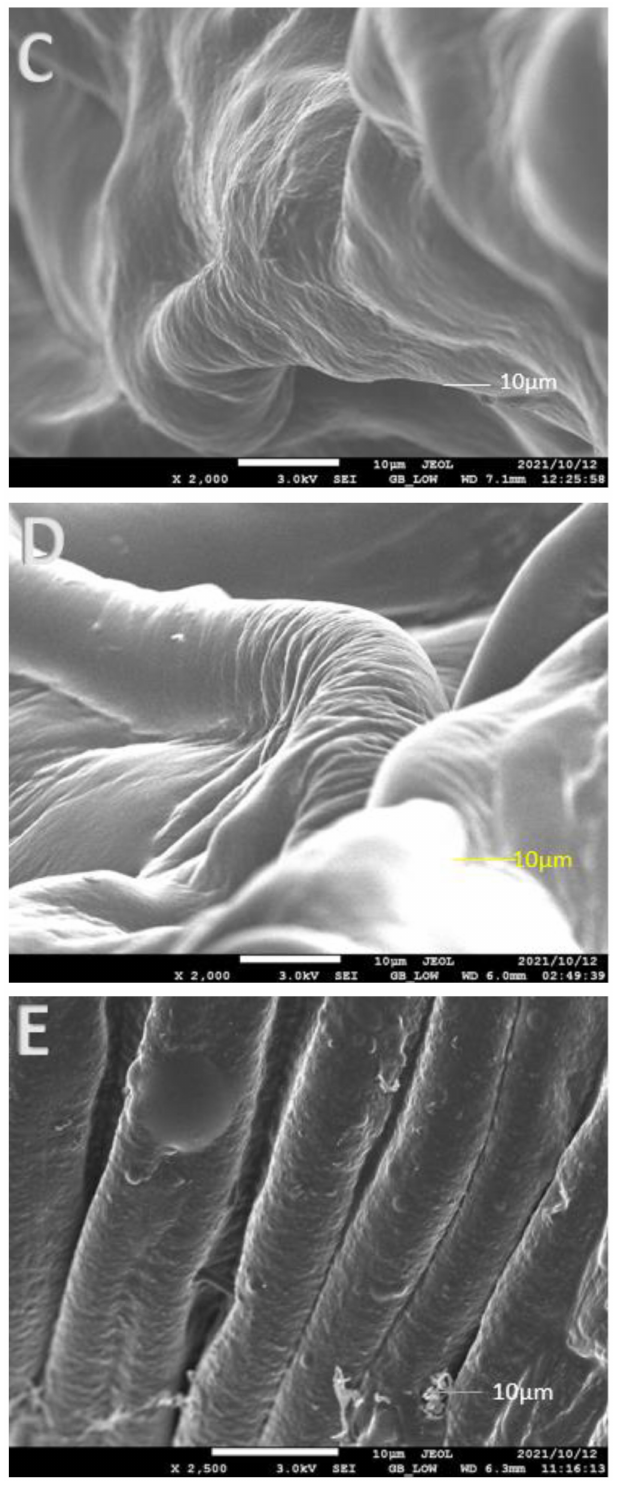
Figure 3. SEM microphotographs of Natal Plum enriched alginate beads and Natal plum pow- der. ( A ): freeze dried Natal plum powder, ( B ): alginate/psyllium mucilage, ( C ): alginate/pectin, ( D ): alginate/xanthan gum, ( E ):